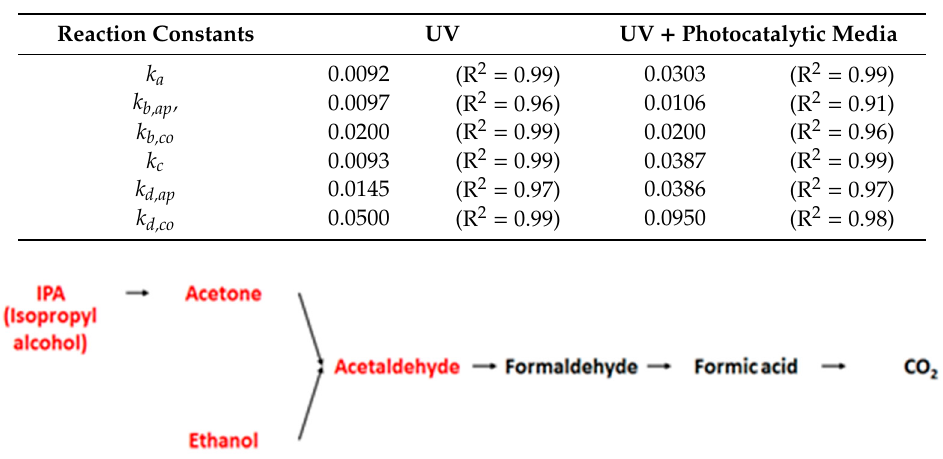
Figure 6. Reaction pathway and relationships of consecutive reaction.